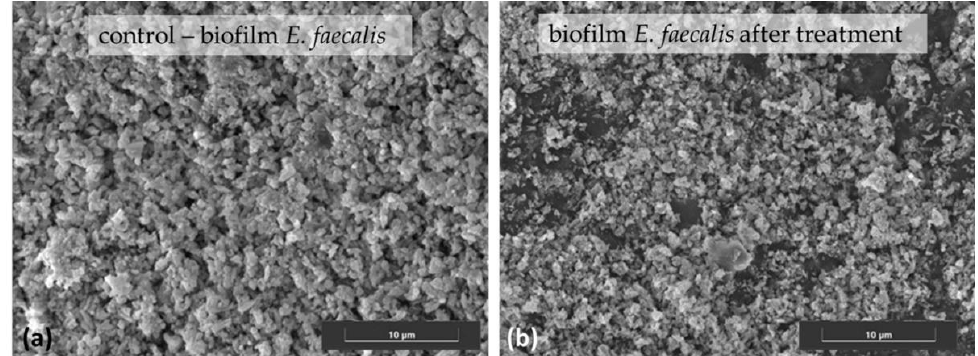
Figure 2. SEM images of E. faecalis on urinary catheter surface ( a ) before and ( b ) after nitroxoline treatment, showing the areas of biofilm destruction. Samples were coated with Pd before analysis on a Hitachi S–3600N Scanning Electron Microscope. Image taken at 13.3 k magnification (scale bar represents 10 μm).